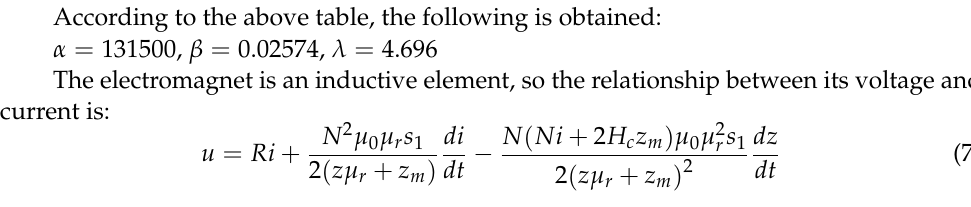
Figure 6. The relationship between electromagnetic attraction force and gap.